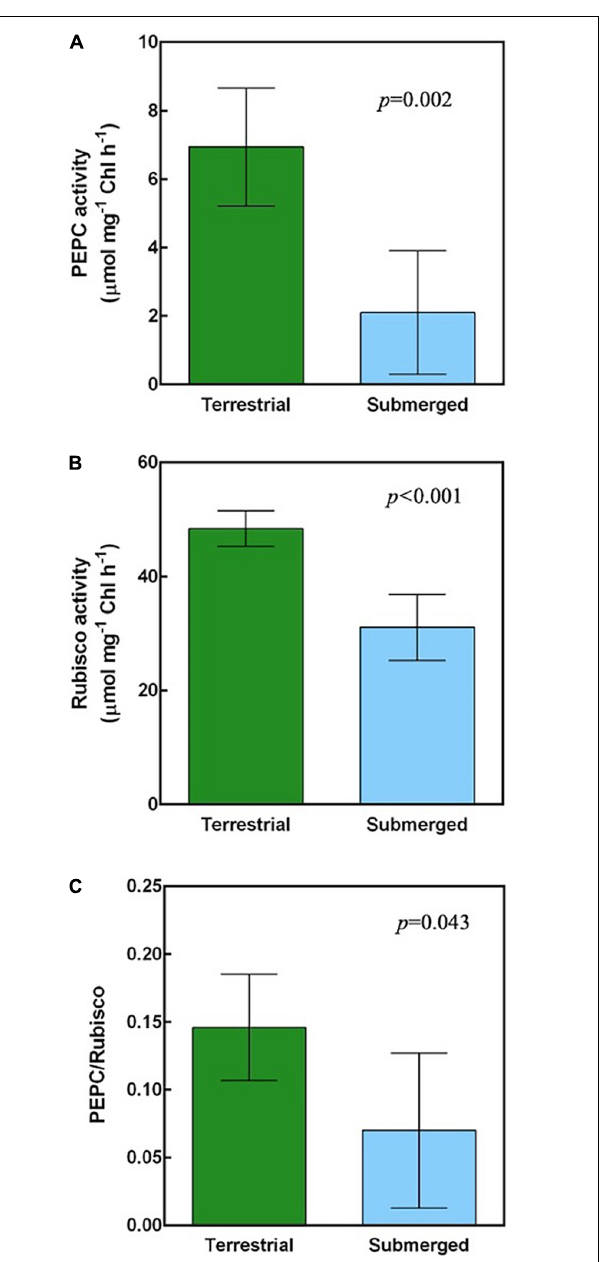
FIGURE 4 | Carboxylation activities of H. polysperma . (A) PEPC activity. (B) Rubisco activity. (C) The ratio of phosphoenol pyruvate carboxylase (PEPC) to Rubisco activity. Data were analyzed with Student’s t test. Results are expressed as means ( n = 5) ± SD. m, mesophyll cell; ue, upper epidermis; le, lower epidermis; bs, bundle sheath cell; a, air space. The arrowhead indicates the chloroplast.